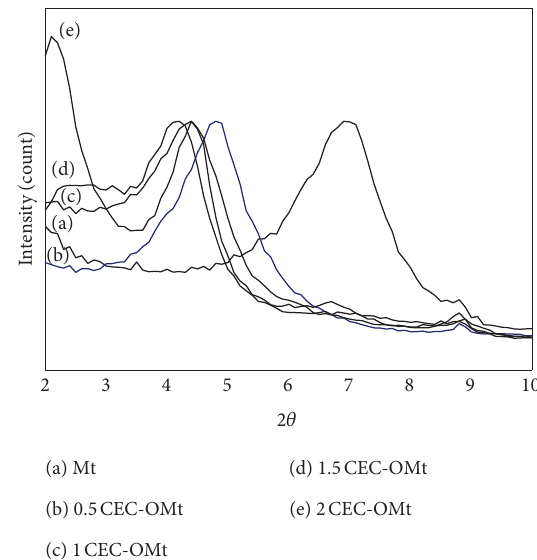
F 2: XRD patterns of the pristine montmorillonite and the different